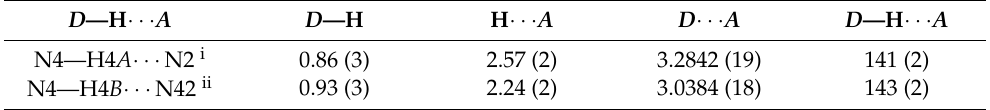
Table 4. Hydrogen-bond geometry (Å, ◦ ) for 3a